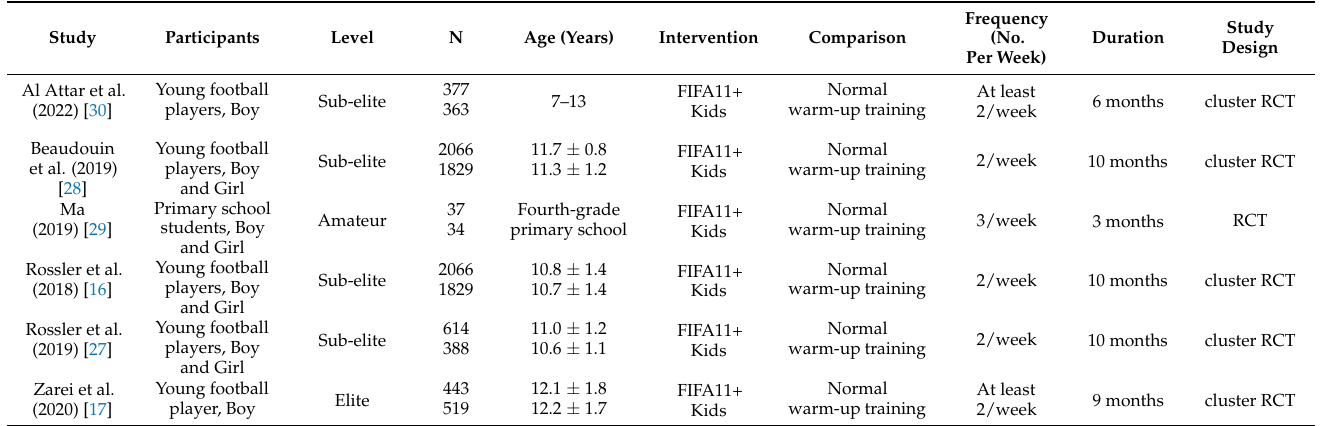
Table A2. Characteristics of the included studies.